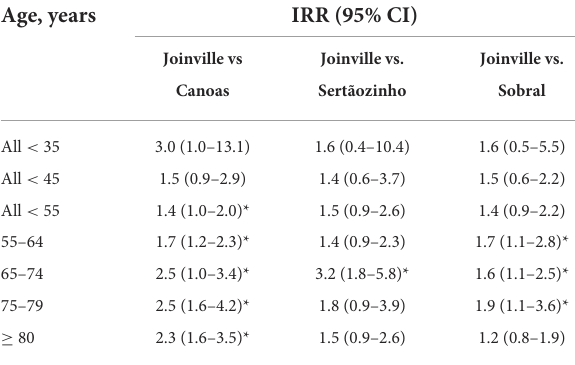
TABLE 3 Relative incidence rates of stroke by age